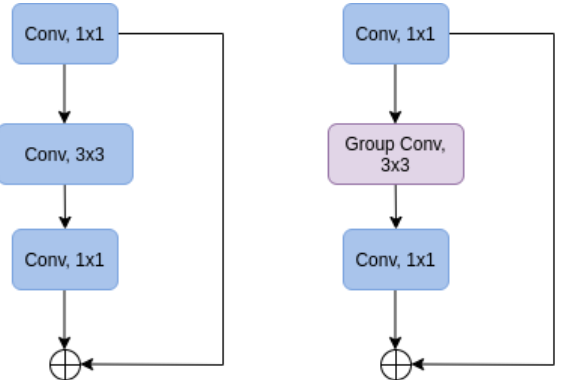
Figure 1. The ResNet ( left ) and ResNeXt ( right ) blocks. The kernel size in each convolution is shown in the